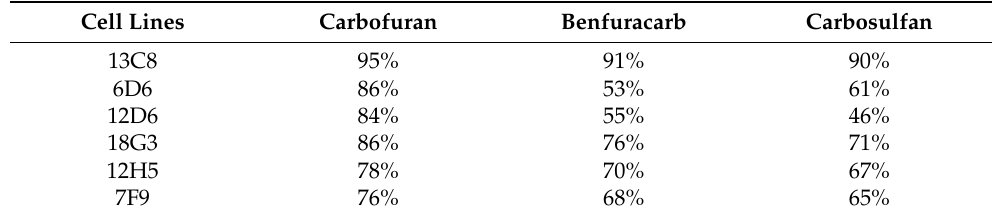
Table 1. Reactivity of mAbs produced by different cell lines to carbofuran, benfuracarb and carbosulfan. Cell Lines